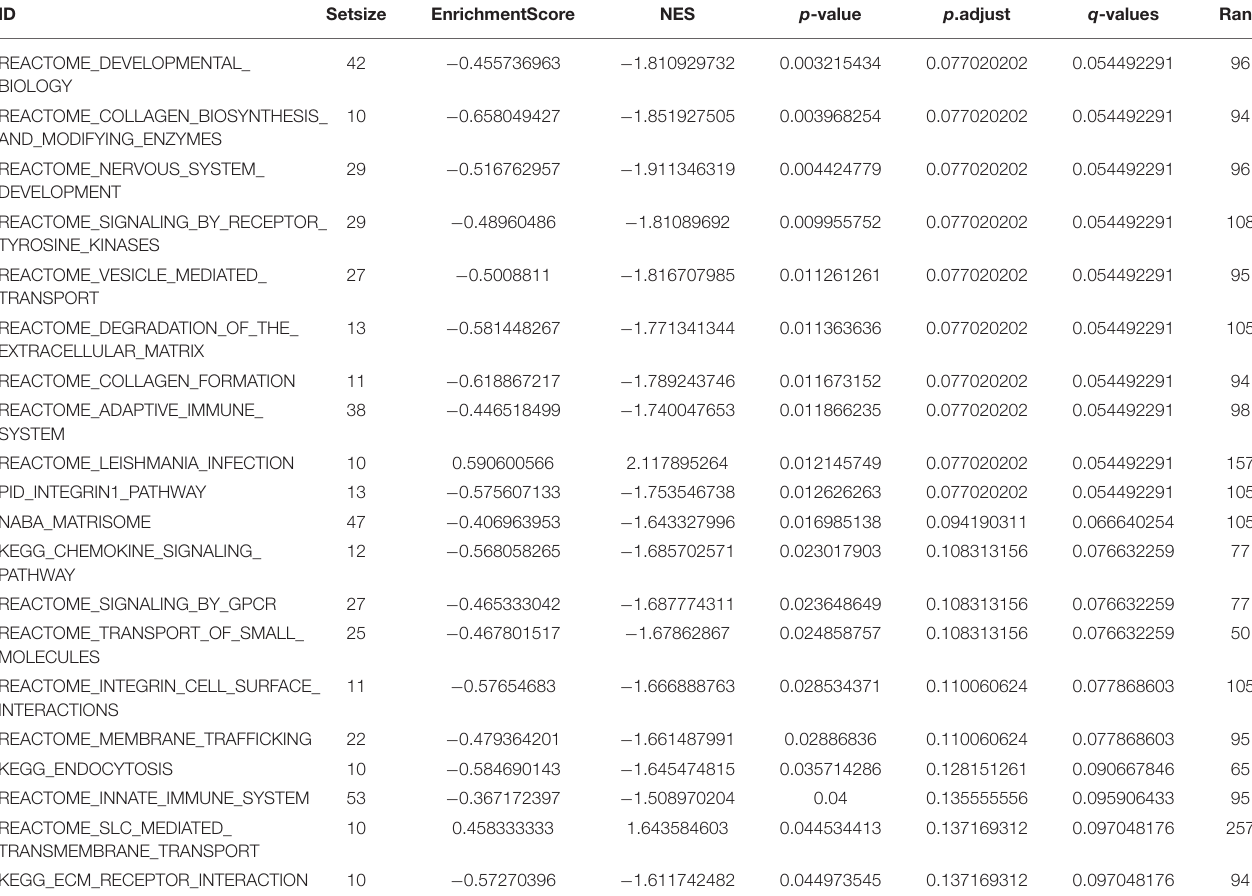
TABLE 2 | The gene set enrichment analysis of 509 DEGs. ID Setsize EnrichmentScore NES p -value p .adjust q -values Rank